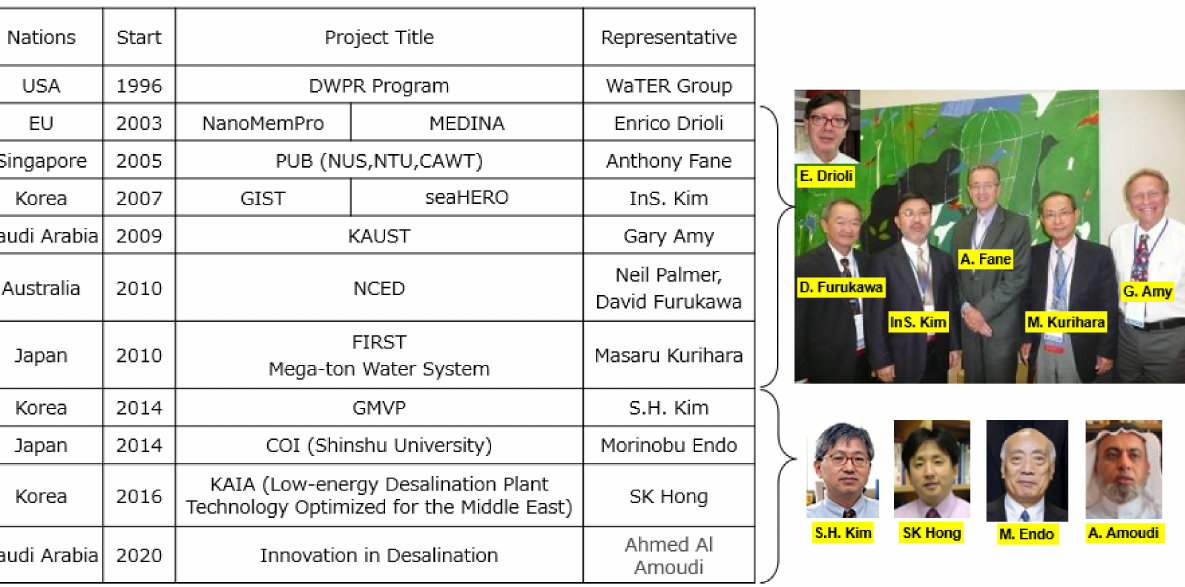
Figure 7. State-sponsored R&D on membrane and membrane process